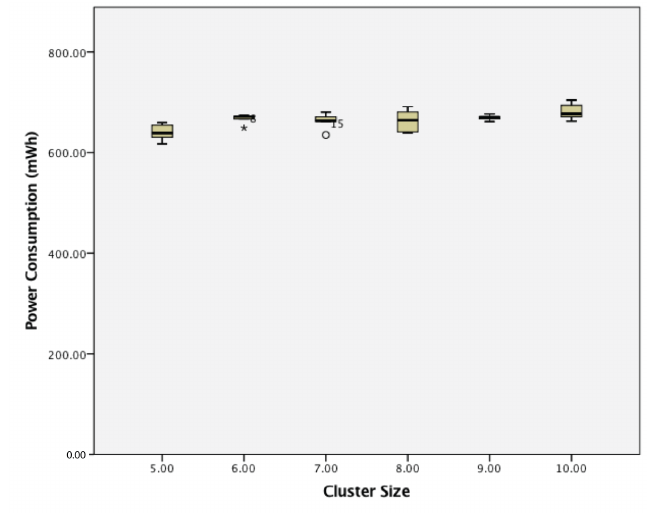
Figure 19. The effect of cluster size on the power consumption of a cluster of active wireless sensor